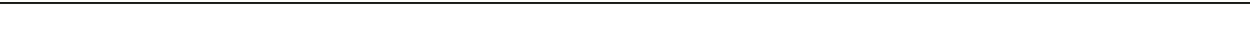
Fig. 4 Conditional deletion of Oxtr delays the morphological maturation of newly generated DGCs. a Confocal three-dimensional reconstruction of dendrites of EGFP + DGCs from WT and Oxtr − / − mice at 14 dpi. Scale bar , 50 µ m. b , c Summary bar graphs depicting b the total dendritic length and c branch number of EGFP + DGCs from WT and Oxtr − / − mice at 14 dpi ( n = 11 neurons from 4 mice per genotype; ** P < 0.01, *** P < 0.001, unpaired two-tailed Student ’ s t test). d Sholl analysis of dendritic complexity of EGFP + DGCs from WT and Oxtr − / − mice at 14 dpi ( n = 11 neurons from 4 mice per genotype; * p < 0.05, ** P < 0.01, two-way ANOVA with Bonferroni ’ s post hoc test). e Representative confocal images showing EGFP + DGCs from WT and Oxtr − / − mice at 28 dpi. Scale bar , 50 µ m. f , g Summary bar graphs depicting f the total dendritic length and g branch number of EGFP + DGCs from WT and Oxtr − / − mice at 28 dpi ( n = 11 neurons from 5 mice per genotype; unpaired two-tailed Student ’ s t test). h Sholl analysis of dendritic complexity of EGFP + DGCs from WT and Oxtr − / − mice at 28 dpi ( n = 11 neurons from 5 mice per genotype; two-way ANOVA). i Top panel , schematic representations of the retroviral vectors used for in vivo genetic manipulation under the control of the Ubi-1 promoter. Bottom panels , representative confocal images showing Retro-EGFP + and Retro-Cre-2A-EGFP + DGCs in Oxtr f/f mice at 14 dpi. Scale bar , 50 µ m. j Summary bar graphs depicting the total dendritic length of Retro-EGFP + and Retro-Cre-2A-EGFP + DGCs in Oxtr f/f mice at 14 dpi ( n = 5 neurons from 3 mice for each group, unpaired two-tailed Student ’ s t test). k Sholl analysis of dendritic complexity of Retro-EGFP + and Retro-Cre-2A-EGFP + DGCs in Oxtr f/f mice at 14 dpi ( n = 5 neurons from 3 mice for each group, two-way ANOVA). Data represent the mean ±